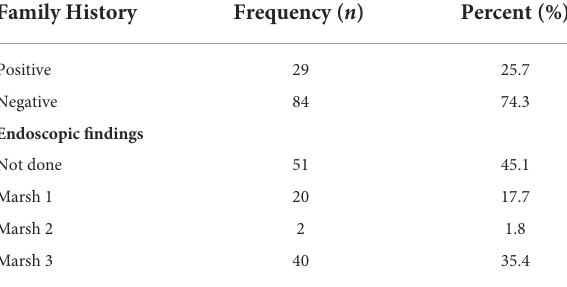
TABLE 5 Disease history and endoscopic findings of patients with celiac